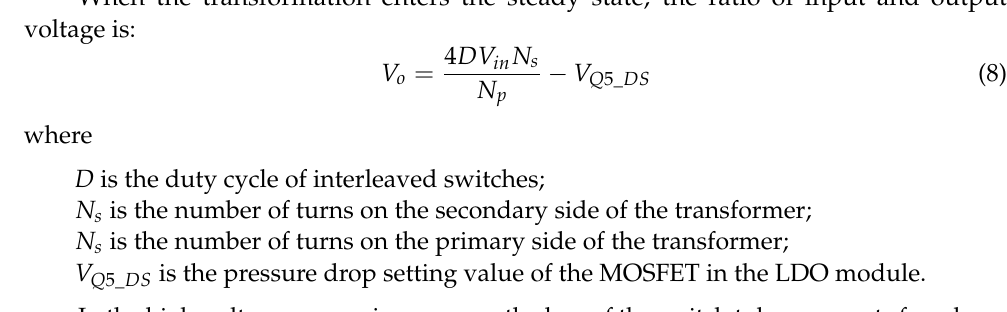
where D is the duty cycle of interleaved switches; N s is the number of turns on the secondary side of the transformer; N s is the number of turns on the primary side of the transformer; V Q 5_ DS is the pressure drop setting value of the MOSFET in the LDO module. In the high-voltage conversion process, the loss of the switch tubes accounts for a large part. To achieve high efficiency, the switch tubes of the second-stage converter (push–pull circuit), which are connected to the third-stage converter (main power converter), should implement a soft switching process, namely, zero-voltage switching (ZVS) and